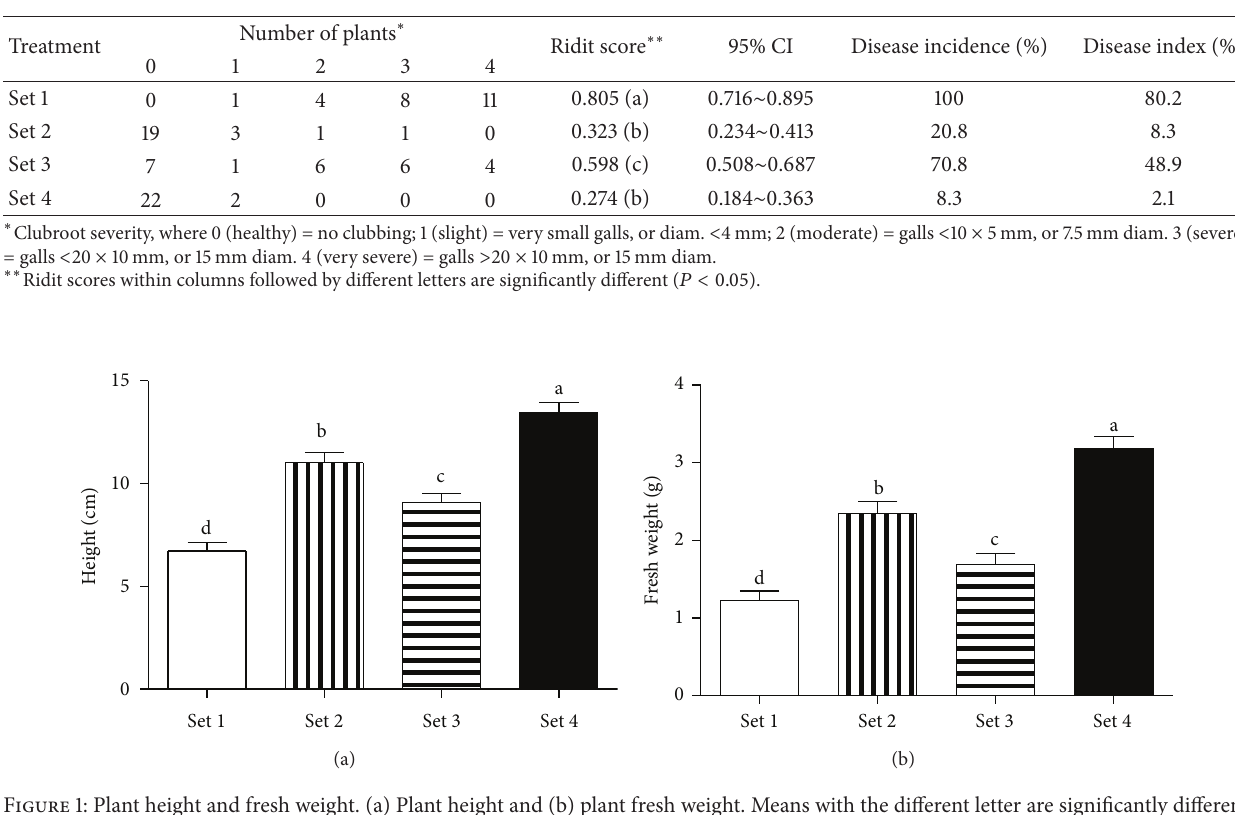
Table 1: Clubroot disease incidence and severity in four sets.